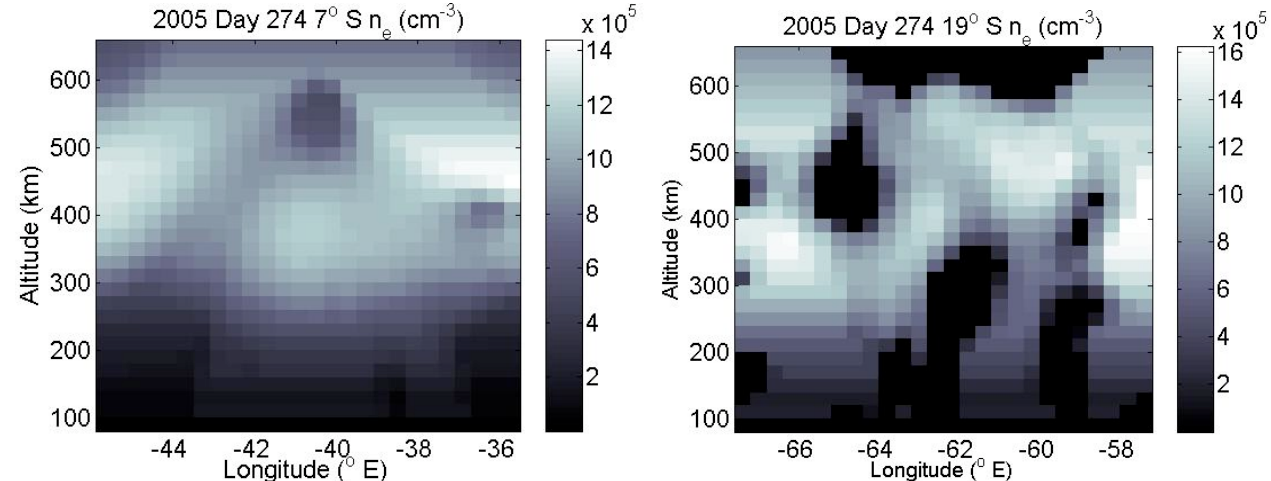
Fig. 4. Vertical cross-sections of electron densities indicative of plasma depletions at 7 ◦ S and 19 ◦ S (left and right) and spanning latitudes of ∼ 36 ◦ to 46 ◦ W and ∼ 57 ◦ to 67 ◦ W, respectively, from tomographic inversions of GUVI 1356 ˚A emissions on successive TIMED orbits over Brazil on 1 October 2005 (day 274). The tomographic inversions enabled horizontal and vertical resolution of 40 and 20km, respectively. Note the very different spatial structures at the ∼ 100-min TIMED orbital sampling